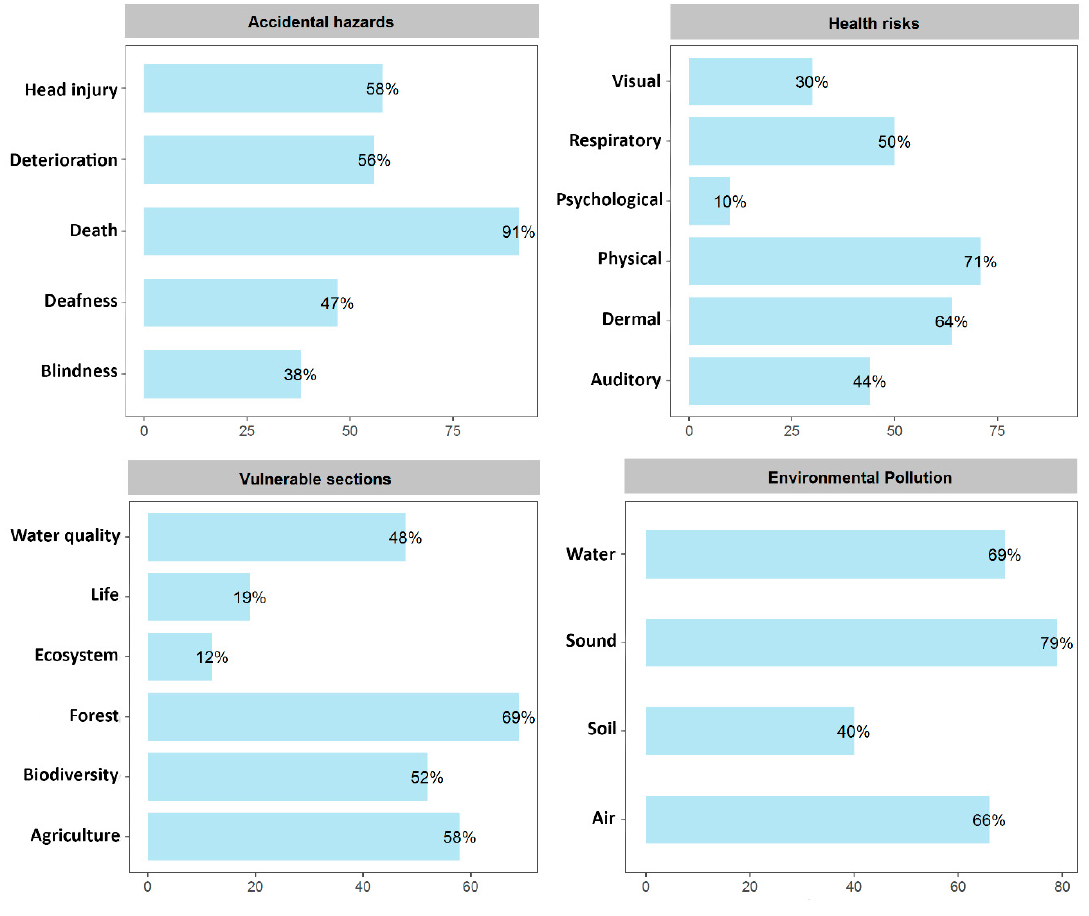
Figure 4. Perceptions of the workers working in shipyards on different hazards.